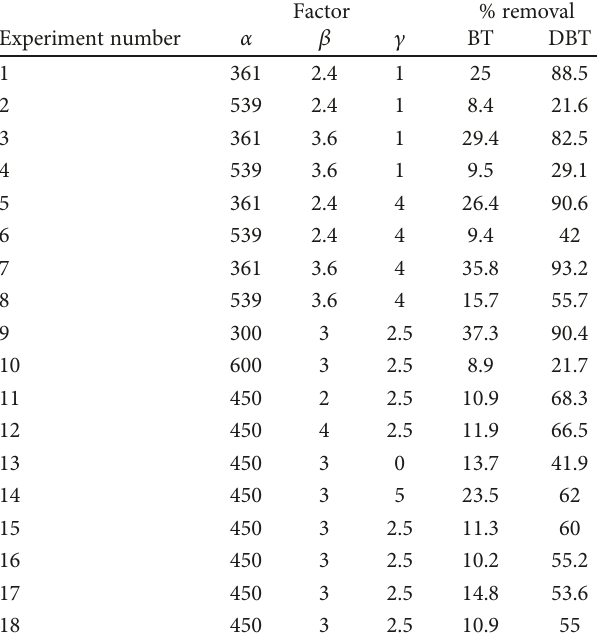
Table 2: Di ff erent experiment conditions and their response values. Factor % removal Figure 1: % DBT removal using composites with di ff erent Experiment number MWCNT :titania